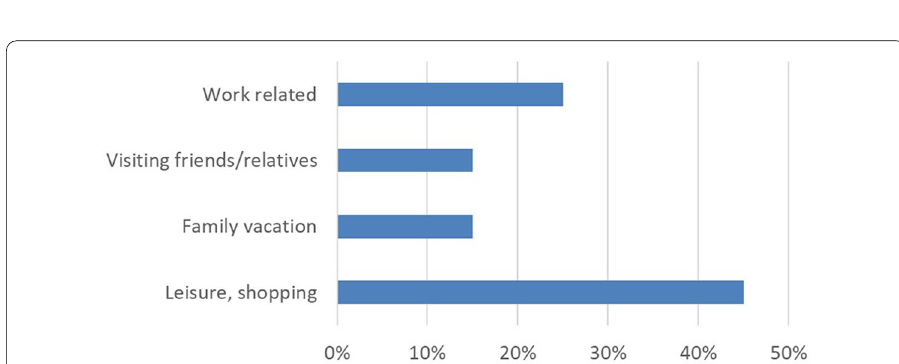
Fig. 4 Reasons for travels for Helsinki-Tallinn trip 2019. Source : Ojala et al. (2020)—author’s own